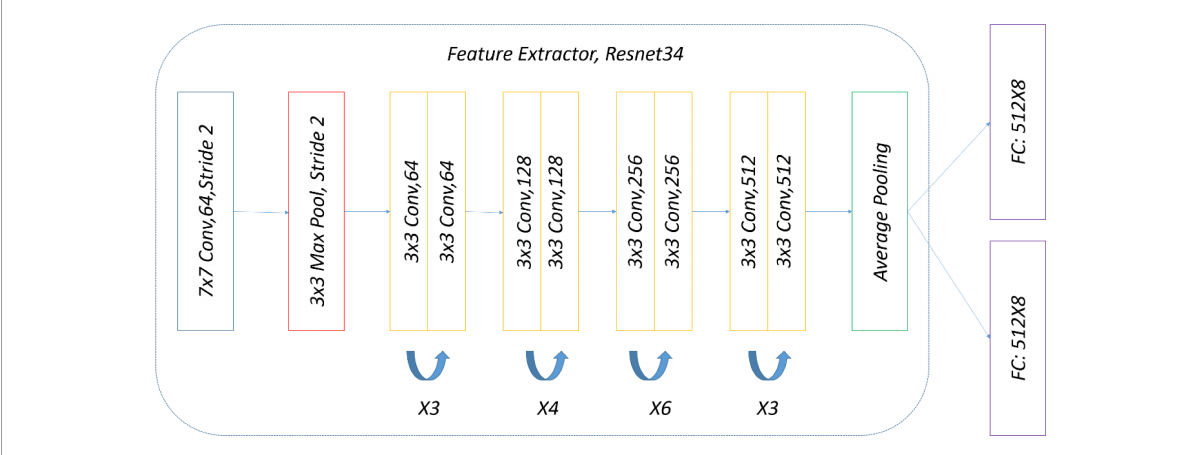
FIGURE8 Two-head network for